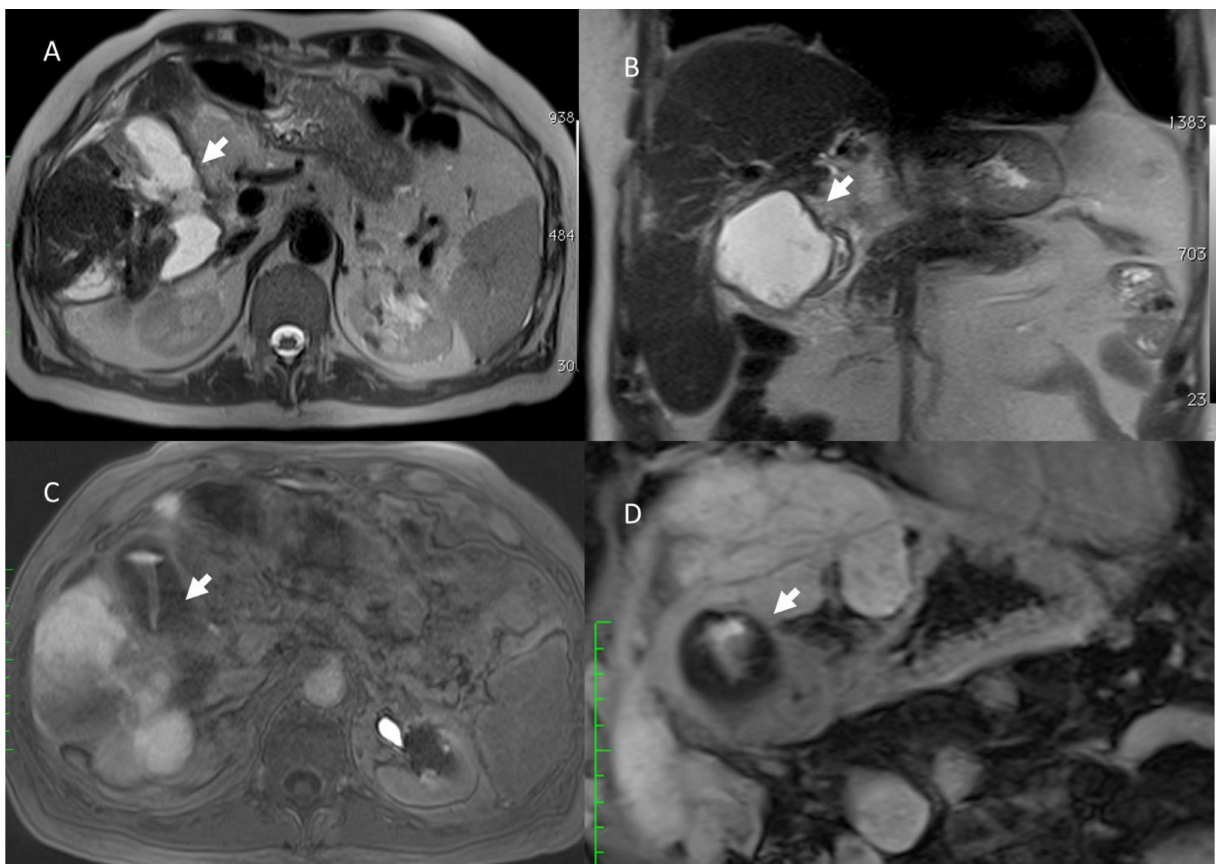
Figure 7. Man 74 years at 1-month follow-up after radio frequency of HCC on VI segment. MRI (( A , B ) HASTE T2-weighted sequences in axial and coronal plane, in ( C , D ) EOB-phase of contrast study in axial and coronal plane). The arrow shows bile